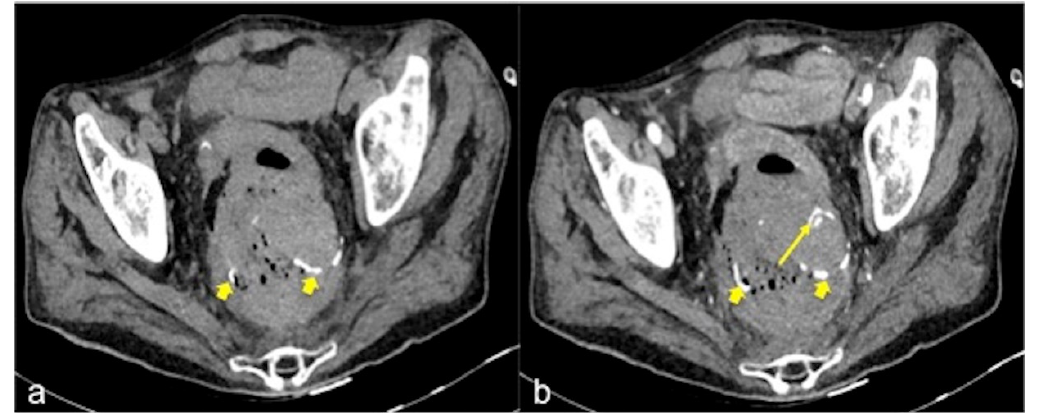
Figure 2. CT multiphasic study of haemorrhage at the surgical site of colorectal anastomosis. The pre-contrast CT axial image ( a ) shows spontaneous hyperdensity of metallic clips (small arrow). The arterial phase ( b ) shows another hyperdense spot (long arrow) near the anastomosis and is suggestive of active bleeding. Table 3. CTA protocol for overt GIB and optional CTE protocol for occult GIB or